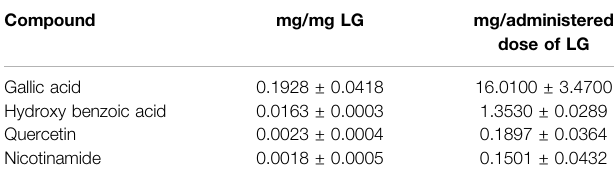
TABLE 2 | Amounts of the selected compounds in LG and in the administered dose of LG.